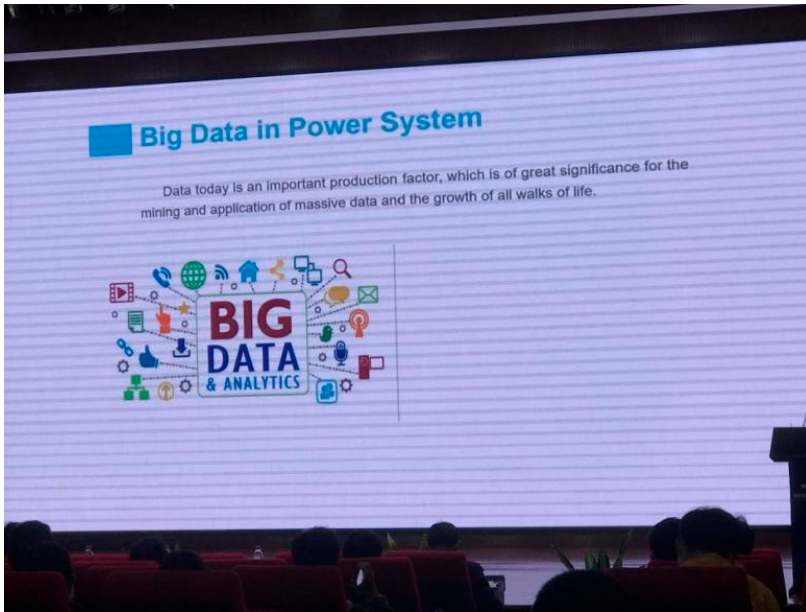
Figure 3. The speech of Professor Goh Hui Hwang: Big Data in Power System.